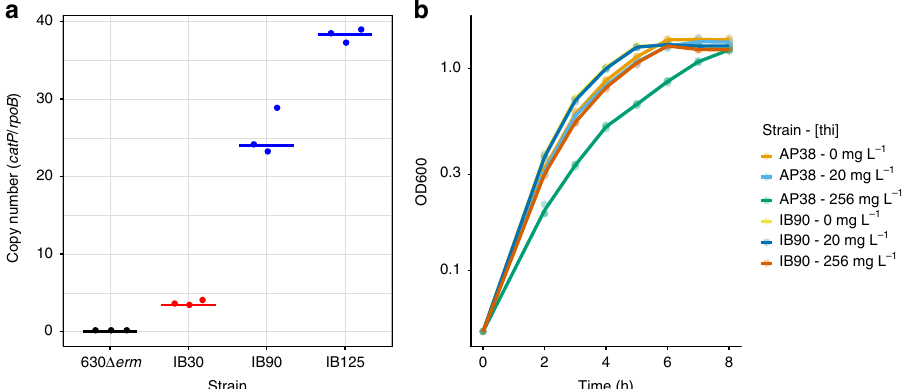
Fig. 7 The pCD-METRO replicon sustains a high plasmid copy number. a 630 Δ erm is the wild type RT012 laboratory strain. IB30: 630 Δ erm + pIB20 (contains pCD6 replicon); IB90: 630 Δ erm + pIB80 (contains pCD-METRO replicon); IB125: 630 Δ erm + pCD-METRO shuttle (pIB86, contains pCD-METRO replicon). Copy number is determined as the ratio of a plasmid locus ( catP ) relative to a chromosomal locus ( rpoB ) as determined by qPCR on total DNA. Data from strains containing a plasmid with the pCD6-replicon are indicated in blue, data from strains containing a plasmid with the pCD-METRO replicon are indicated in red. Individual data points are plotted using symbols. Horizontal lines indicate median values. 630 Δ erm vs IB30: P = 0.1018; IB90 vs. IB125: P = 0.0002; other comparisons: P < 0.0001 as determined by two-sided ANOVA and Tukey ’ s test. Experiments were performed in triplicate on three different technical replicates. b A strain derived from the laboratory RT012 strain 630 Δ erm harboring a plasmid containing the pCD-METRO replicon (IB90) has a growth advantage over a strain containing a plasmid with the pCD6 replicon (AP38) when cultured at high levels of thiamphenicol (thi). AP38: 630 Δ erm + pAP24 (pCD6 replicon); IB90: 630 Δ erm + pIB80 (pCD-METRO replicon). Growth is measured as an increase in optical density at 600 nm (OD600). Solid line indicates the mean of the individual measurements that are shown using dots ( n = 3 biologically independent samples). Source data are provided as a Source Data fi